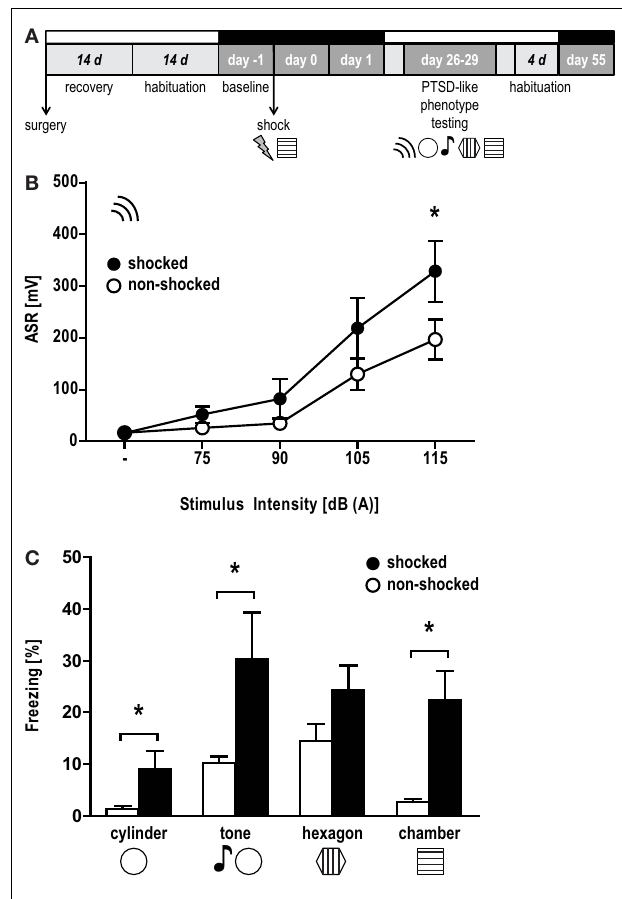
FIGURE 1 | Hyperarousal, contextual, and generalized fear in the aftermath of a trauma . (A) Experimental design: mice were implanted with EEG and EMG electrodes (surgery), after which they were allowed to recover for 14days.The subsequent habituation period to the recording cable-swivel system lasted for 14days. EEG/EMG recordings are indicated by black bars above the respective days (baseline, day 0, day 1, day 55). On day 0, animals were exposed to two electric foot shocks (1.5mA, 2s) in the shock context. PTSD-like symptoms were assessed 1month later (day 26–29) in the following order: (i) the acoustic startle response (ASR) and freezing behavior upon exposure to (ii) a completely new context (“cylinder”), (iii) a neutral tone in the cylinder (“tone”), (iv) a conditioning situation reminder context (“hexagon”), and (v) the original conditioning context (“chamber”). (B) ASR presented as group mean ± SEM based on 20 trials for each intensity presented in pseudorandom order. * p < 0.05 between shocked (black) vs. non-shocked control (white) group (unpaired t -test, one-tailed). (C) Percent time animals spent freezing (mean ± SEM). * p < 0.05 between shocked (black) vs. non-shocked (white) mice (unpaired t